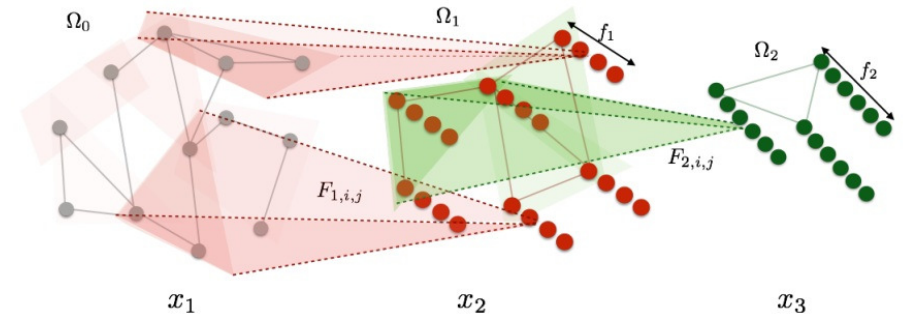
Figure 16. Spatial construction of geometric CNN. K(K = 2 in the example) scales are considered. Ω k is defined as a partition of Ω k ´ 1 into d k clusters. Each layer of the network transforms a f k ´ 1 -dimensional signal indexed by Ω k ´ 1 into a f k -dimensional signal indexed by Ω k . The figure is originally from